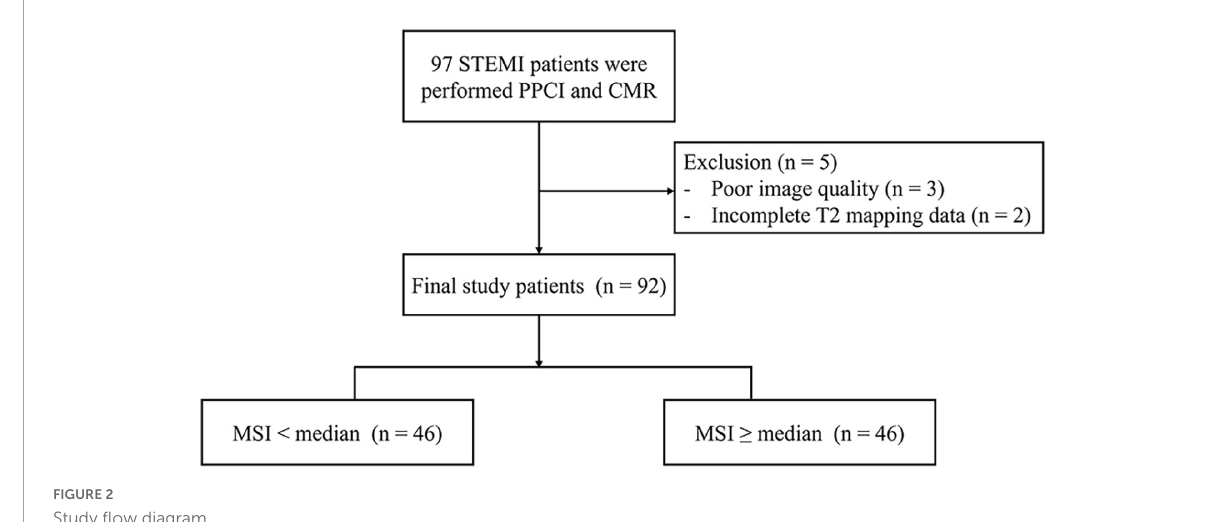
FIGURE2 Study flow